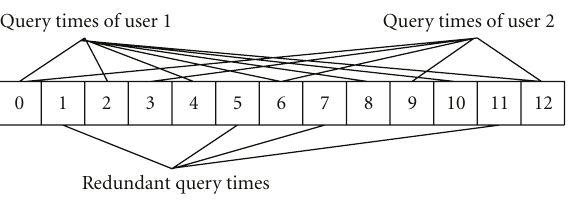
Figure 2: Example of multirate